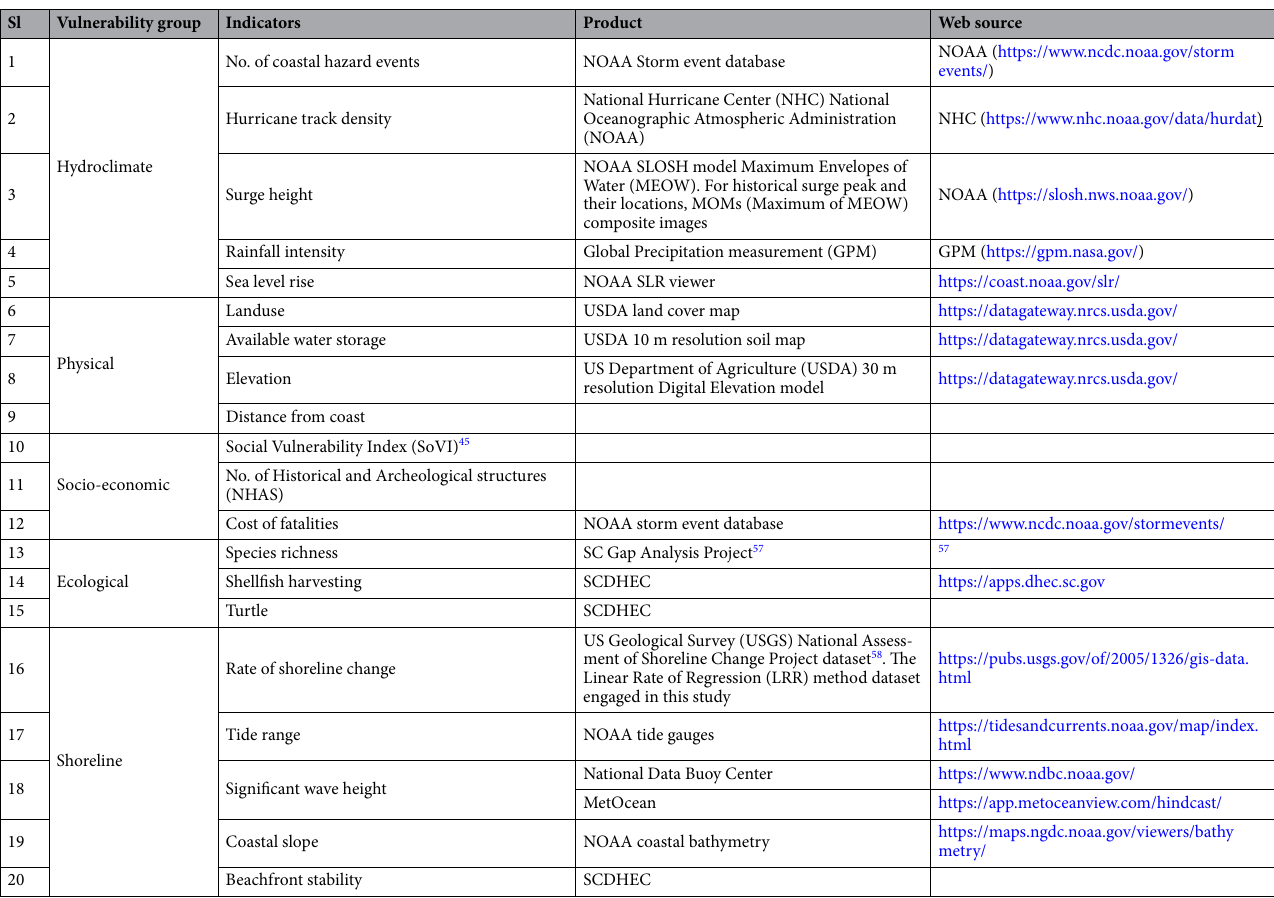
Table 2. Sources of data acquired for coastal vulnerability